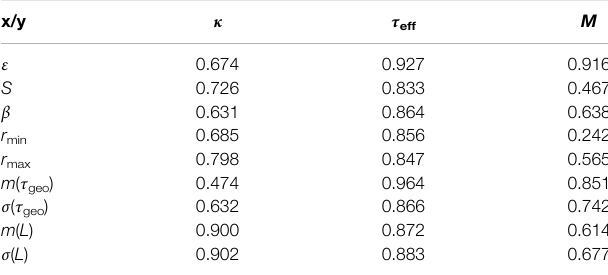
TABLE 1 | Functional dependence measure δ ( x , y ) between a scalar structural descriptor x and an effective property y .